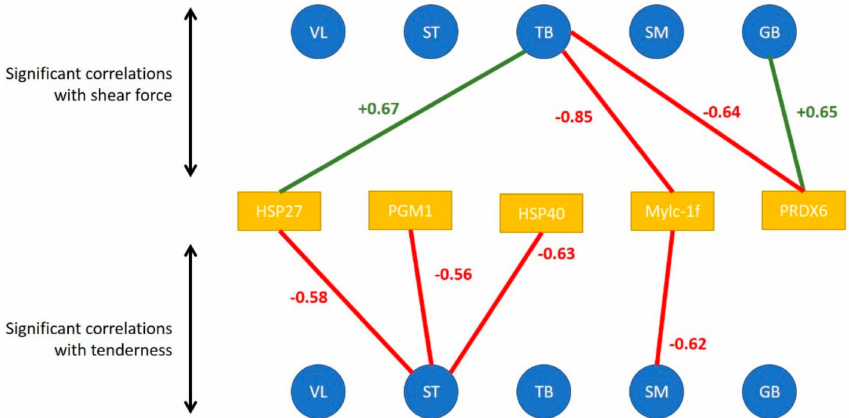
Figure 3. Significant correlations between tenderness / shear force of each muscle (represented by the blue disks) and the abundance of muscular biomarkers of the concerned muscle (represented by the orange rectangles). Red values correspond to negative correlations and green ones to negative